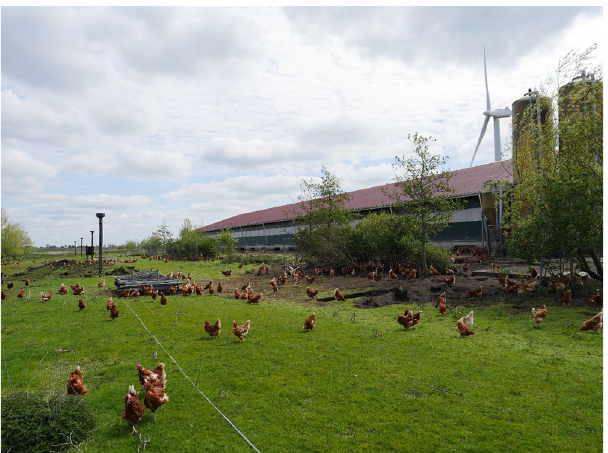
Figure 2. Wide-angle video-cameras installed at a height of approximately 4 m above ground-level on poles in the free-range study area (source: photo by first